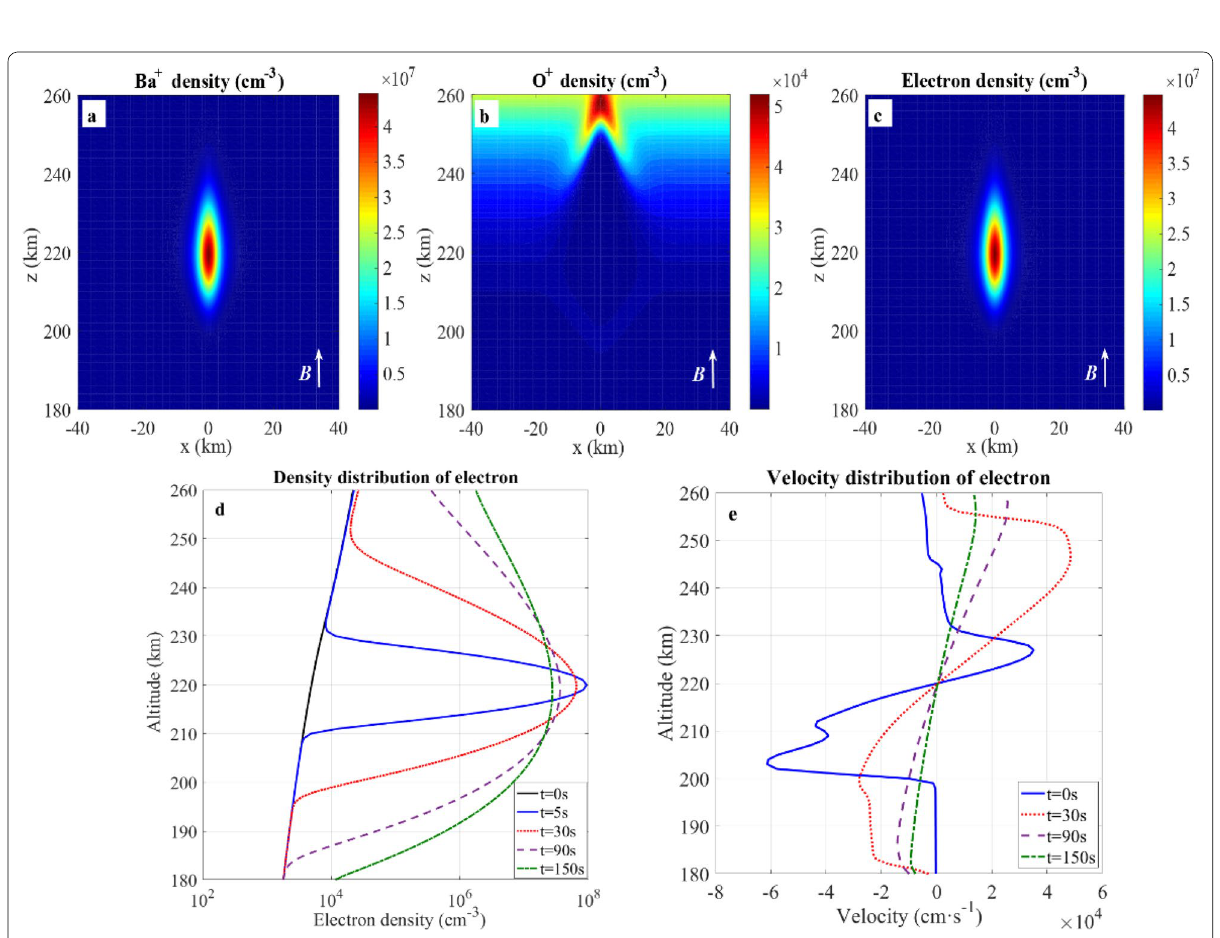
Fig. 10 The plasma cloud distribution in the x–z plane (at t distribution of electron density and velocity over height at different times ( d , e ). The maximum densities at t